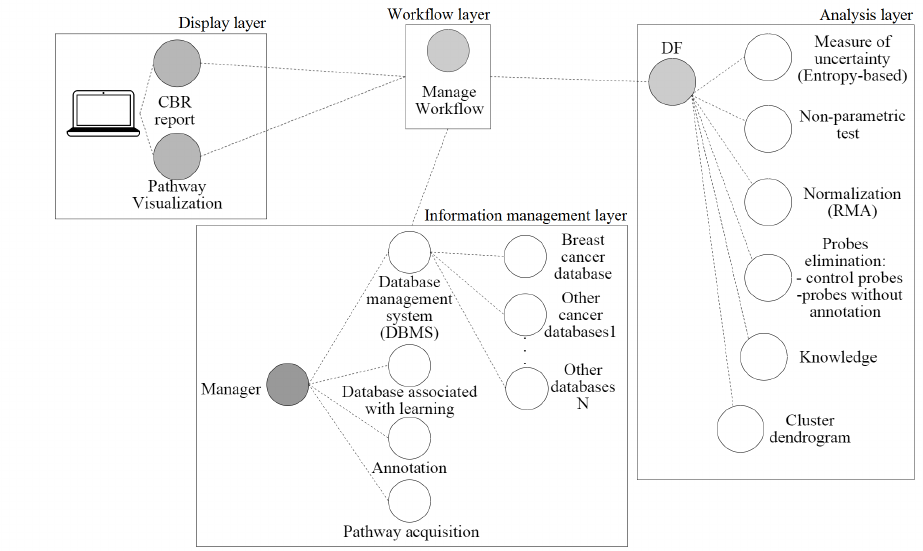
Figure 1: Multi-agent System